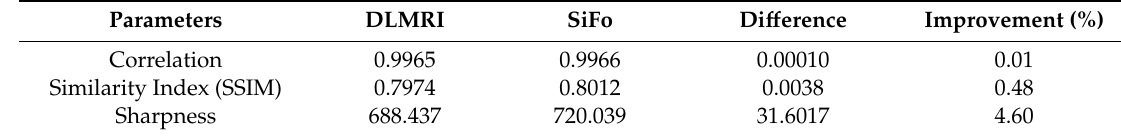
Table 3. Performance parameter of Algorithm with noisy case for Brain Image with Radial sampling.